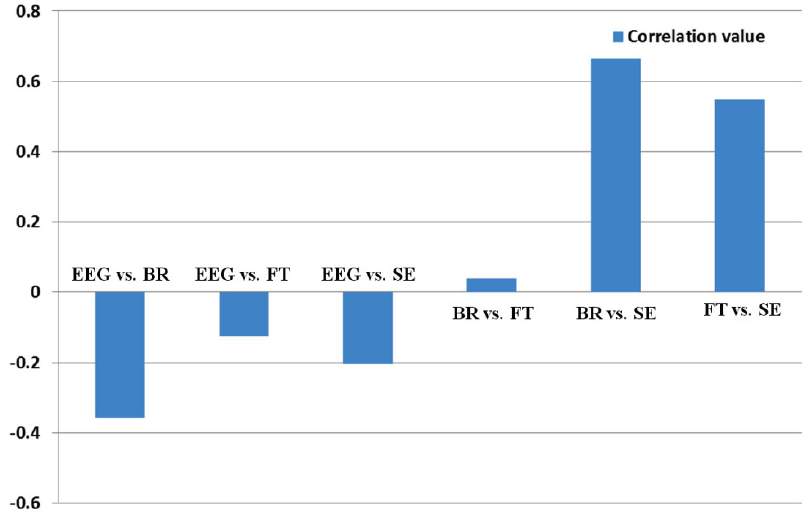
Figure 14. Calculated correlation value between each set of measurement.